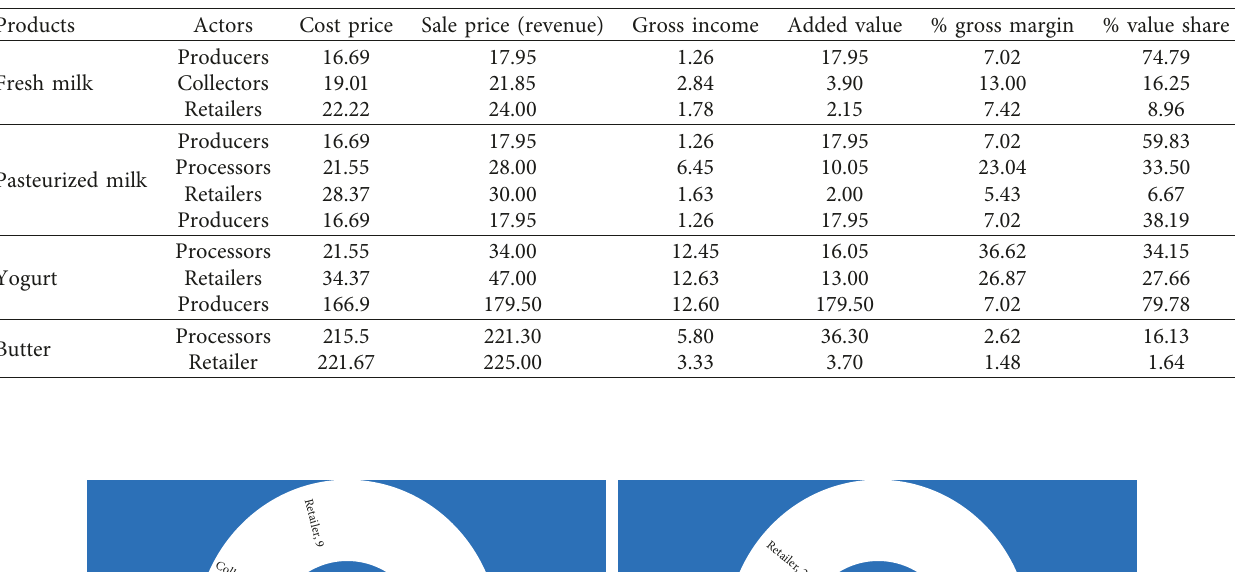
Table 7: Gross margin and value shares of dairy value chain actors.